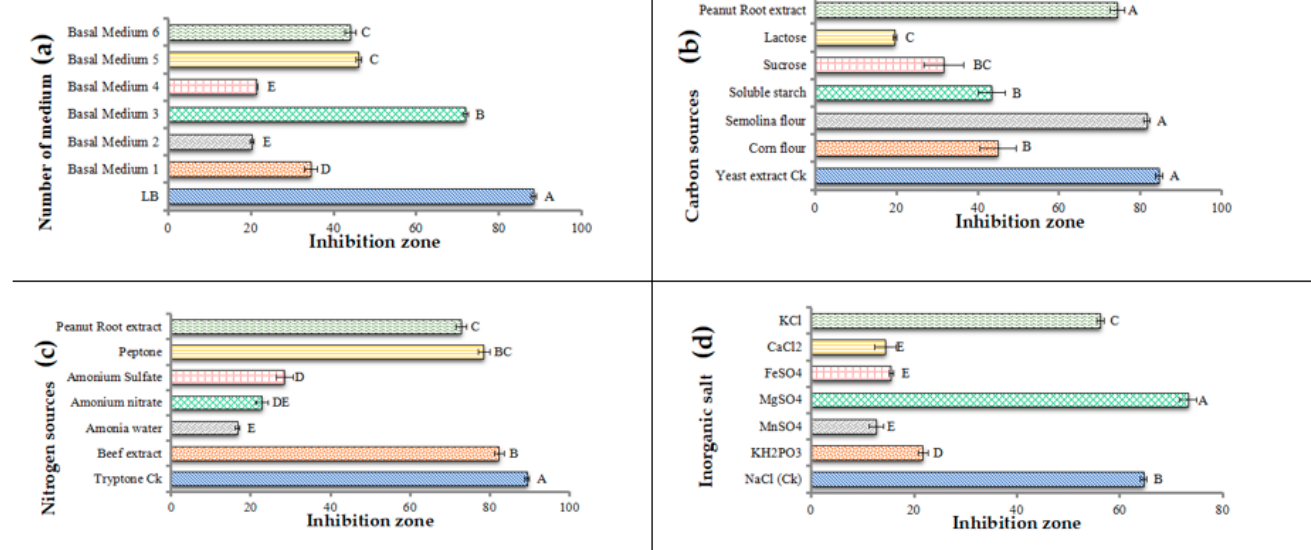
Figure 1. One factor, one time screening of fermentation medium of B. amyloliquefaciens BAM with different basal media ( a ), carbon sources ( b ), nitrogen sources ( c ), and inorganic salts ( d ). Means sharing similar letters in a column are statistically significant.